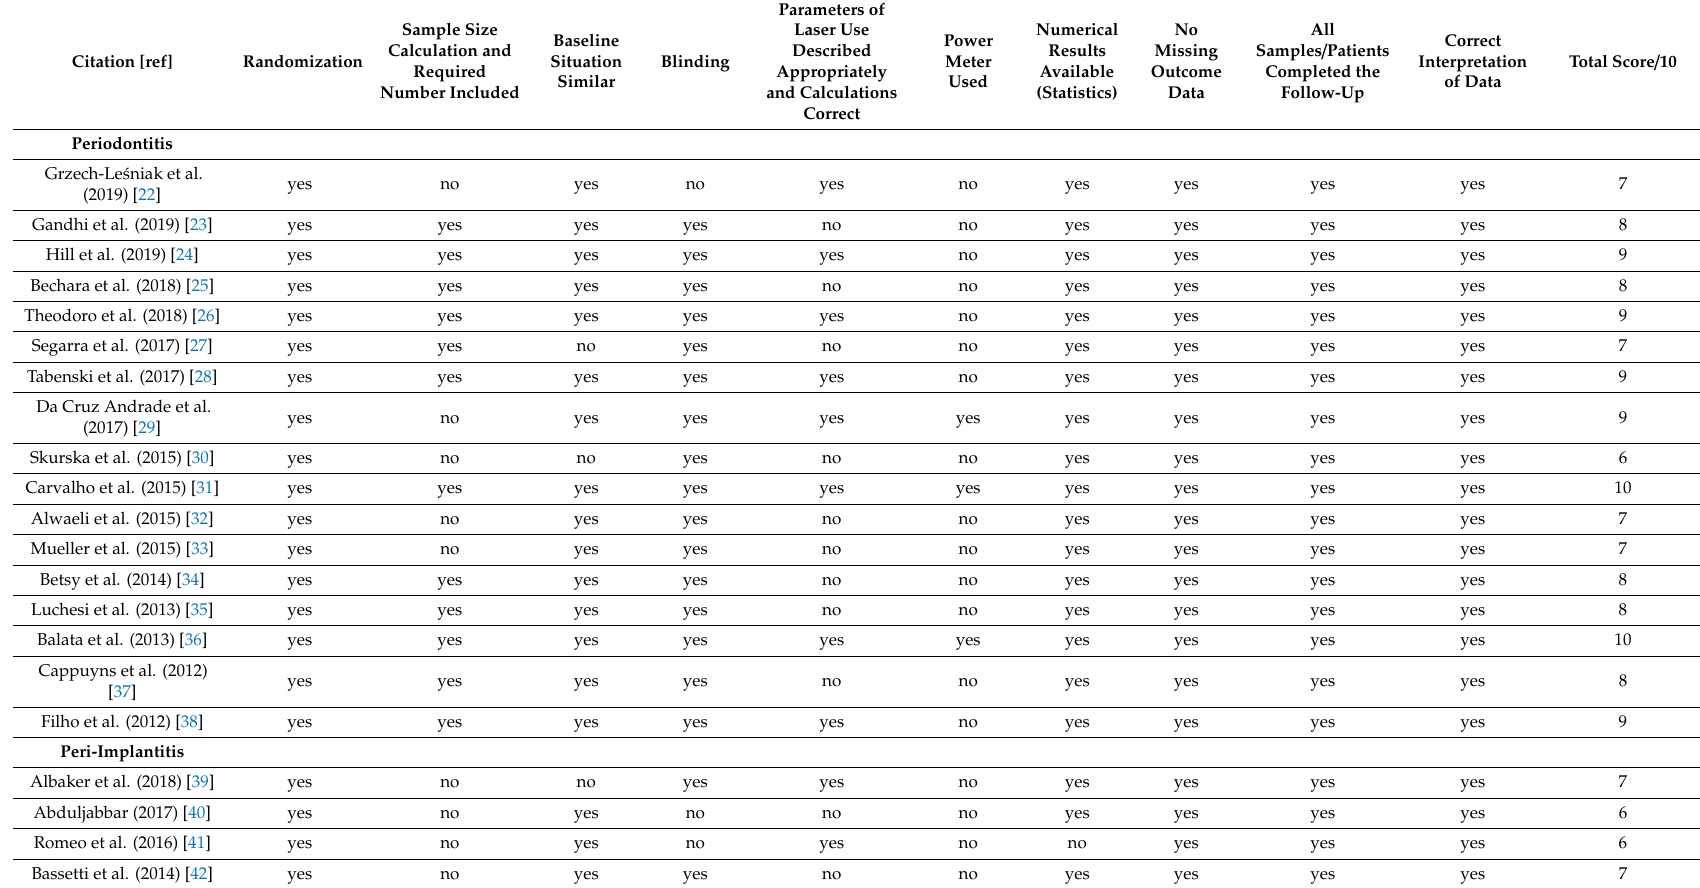
Table 8. Risk of bias assessment